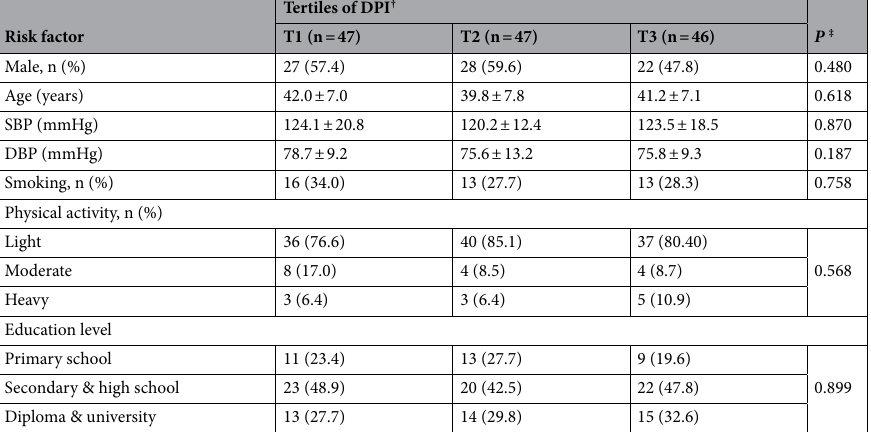
Table 3 indicates the anthropometric indices and metabolic, inflammatory, and oxidative stress markers of study subjects across tertiles of DPI. There were no significant differences in the mean weight, BMI, and WC across tertiles of DPI. The mean serum concentrations of TG ( P -trend = 0.005) and hs-CRP ( P -trend = 0.002) had decreasing trends across the increasing in DPI scores. The subjects in third tertile of DPI had lower serum concentrations of TG and hs-CRP compared to the counterparts in the first tertile ( P < 0.05 for both). No signifi- cant regular trend was observed regarding FBS, TC, LDL-C, and HDL-C across DPI tertile categories. There was a trend towards decreasing serum concentrations of MDA ( P -trend = 0.001) and TOS ( P -trend = 0.013) as well as erythrocytes SOD activity ( P -trend = 0.013) with increasing tertiles of DPI. Indeed, the subjects in the top tertile of DPI had lower serum concentrations of MDA and TOS as well as erythrocytes SOD activity compared to the subjects in the first tertile ( P < 0.05 for all). Inversely, serum TAC concentration had increasing trend across the increasing in DPI categories ( P -trend = 0.015) so that, subjects in the third tertile of DPI had higher serum TAC concentration compared to the counterparts in the first tertile ( P < 0.05). Nonetheless, no significant associations